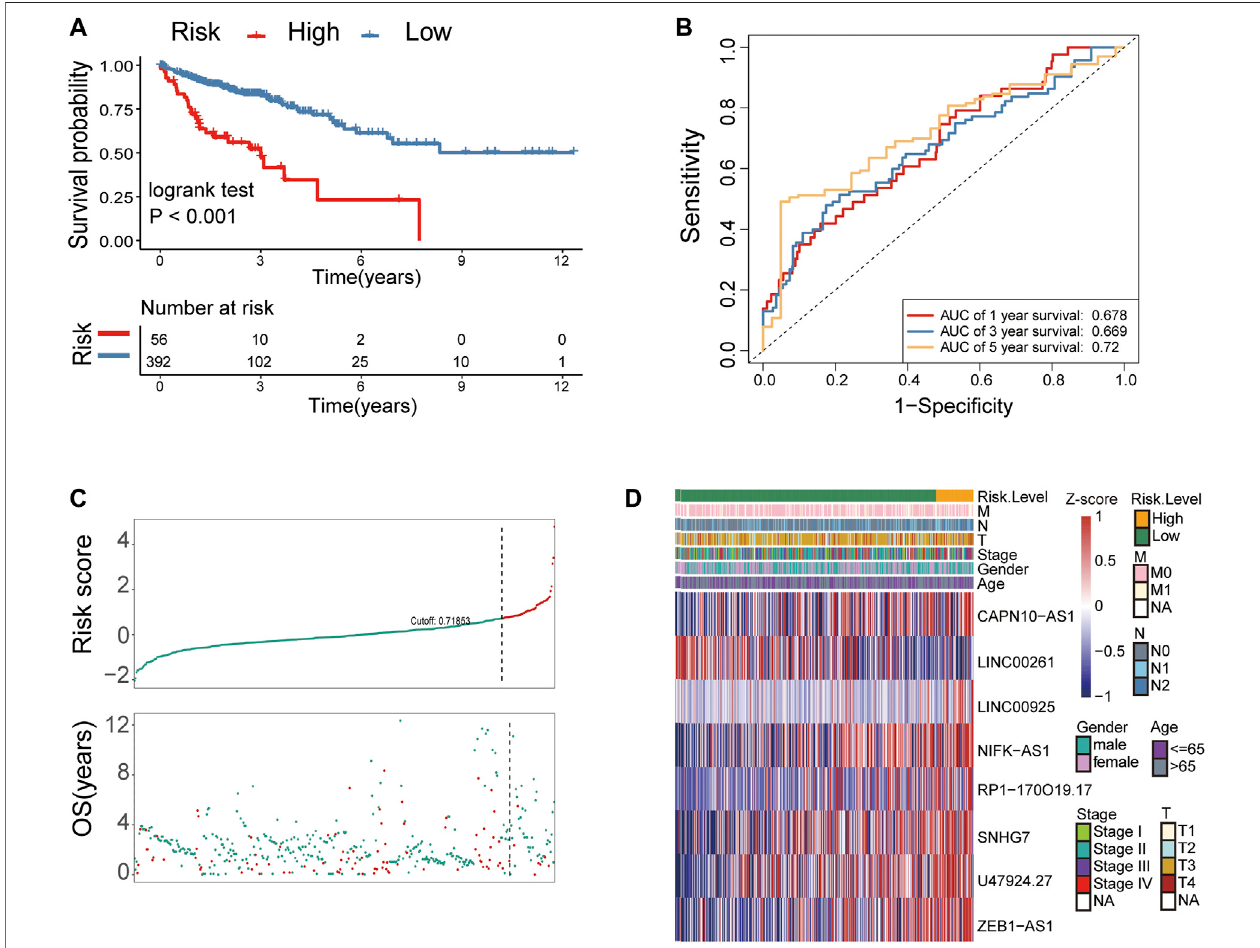
FIGURE3| Identi fi cation ofmetastasis-related lncRNAprognostic signatures forCRC inthe TCGA cohort. (A) Patients inthehigh-riskgroup (red) exhibitedworse overall survival (OS) than those in the low-risk group (blue) in the TCGA cohort. (B) Receiver operator characteristic (ROC) curves predicted the sensitivity and speci fi city of 1-, 3-, and 5-year survival according to the 8-lncRNA signature-derived risk scores in the TCGA cohort. (C) The distribution and value of the risk scores in the TCGA cohort. (D) The expression of eight lncRNAs in CRC patients.